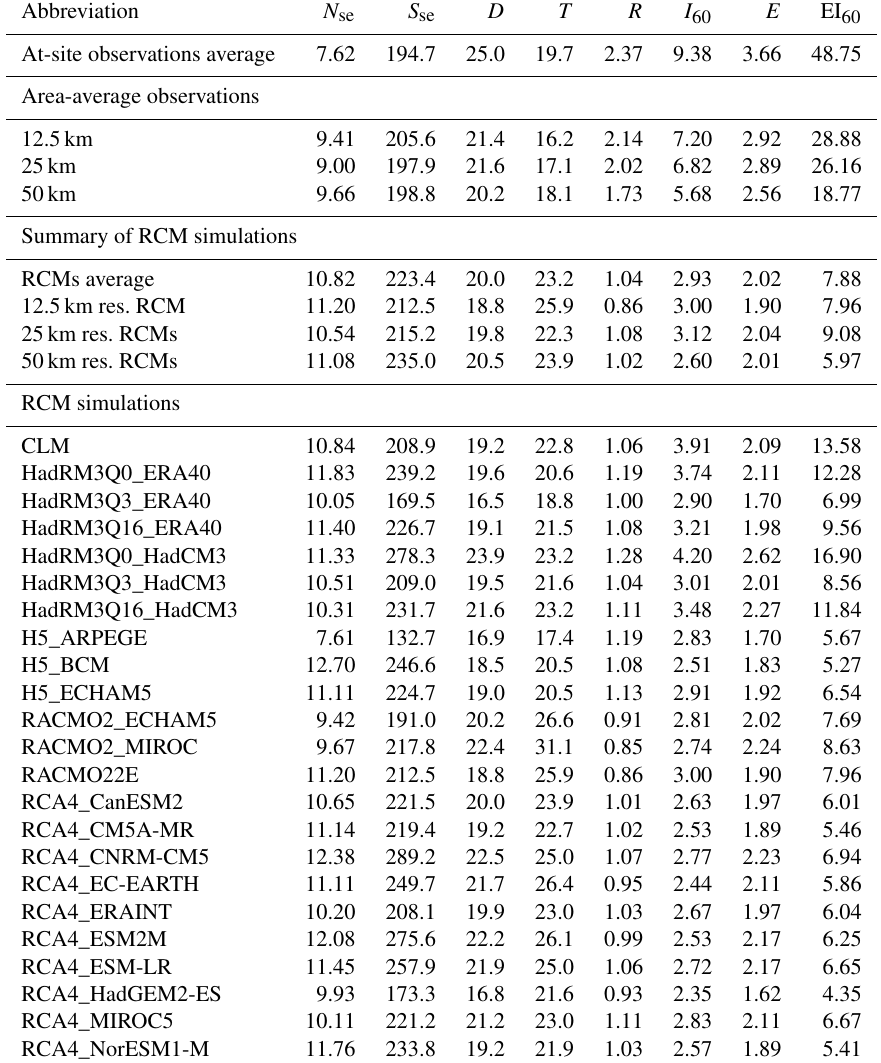
Table 2. Seasonal number of heavy rainfall events ( N se ( − )), seasonal total precipitation due to heavy events ( S se (mm)), and mean rainfall event characteristics (depth D (mm), duration T (h), mean rainfall rate R (mmh − 1 ), maximum 60min intensity I 60 (mmh − 1 ), rainfall energy E (MJha − 1 ), and rainfall erosivity index EI 60 (MJmmha − 1 h − 1 )) for the 1981–2000 period in the observed data (top four rows) and the RCM